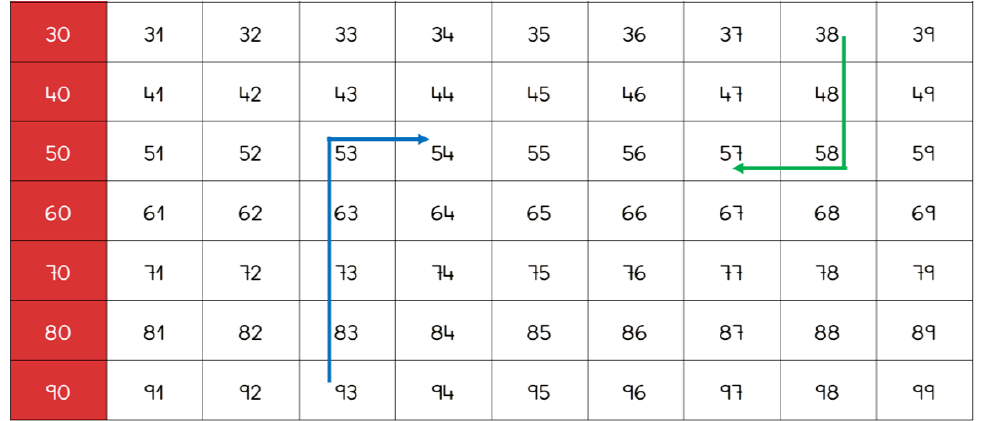
Figure 14. Detail of two path on the panel. Acquisition of more complex calculation strategies: when the group reaches a good level of mastery, the panel format can be extended to the hundreds to work with numbers